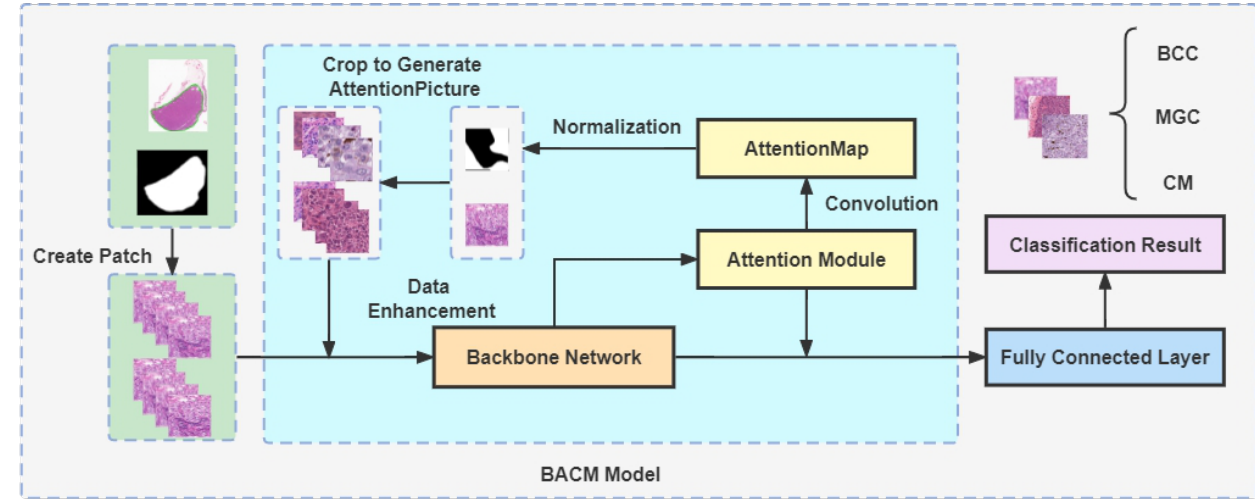
Figure 2. Details of BACM Model: This Network is referenced from the fine-grained classification model WSDAN and modified on its basis. The backbone network migrates the trained network parameters of the Imagenet dataset as the initial values of the network